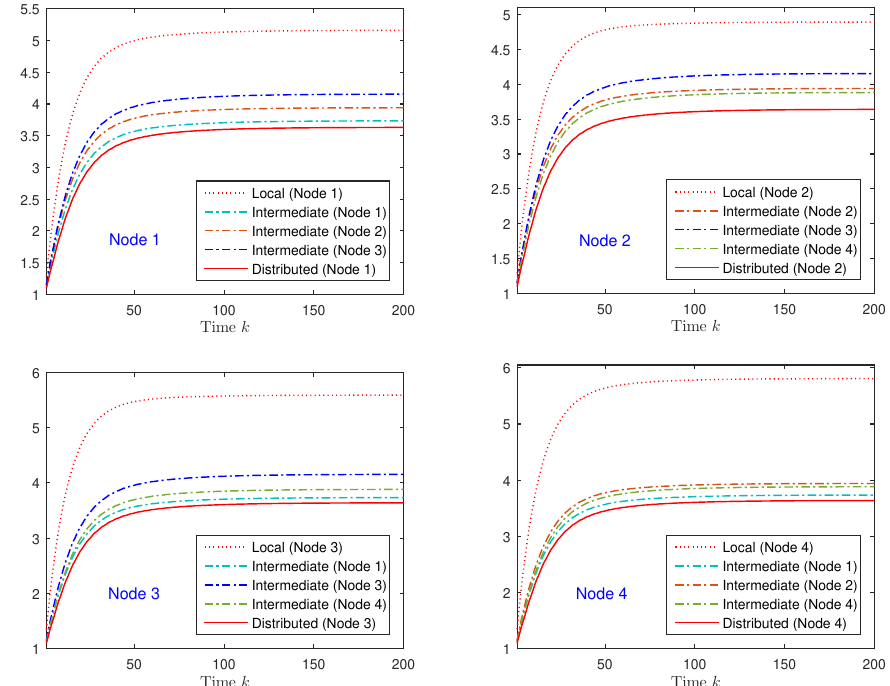
Figure 1. Error variance comparison of the local, intermediate, and distributed filtering estimators for the first component of the state vector.